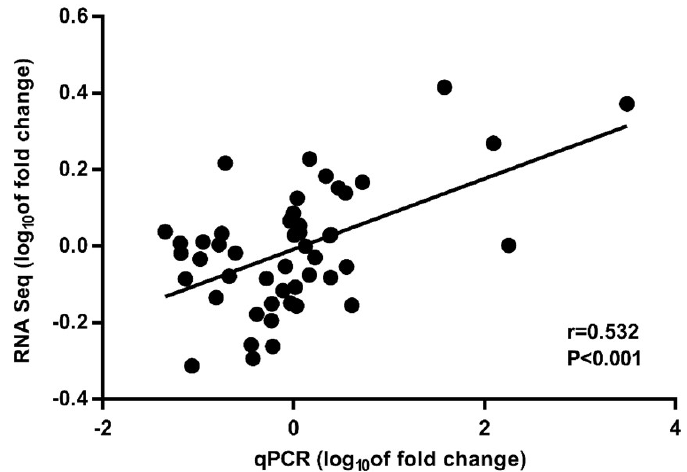
Figure 2. Correlation between RT-qPCR and RNA sequencing of 12 genes. Each point represents a multiple of the expression level at d 34 or d 51, at d 17 or d 34. Change in power is log base 10 transformation.